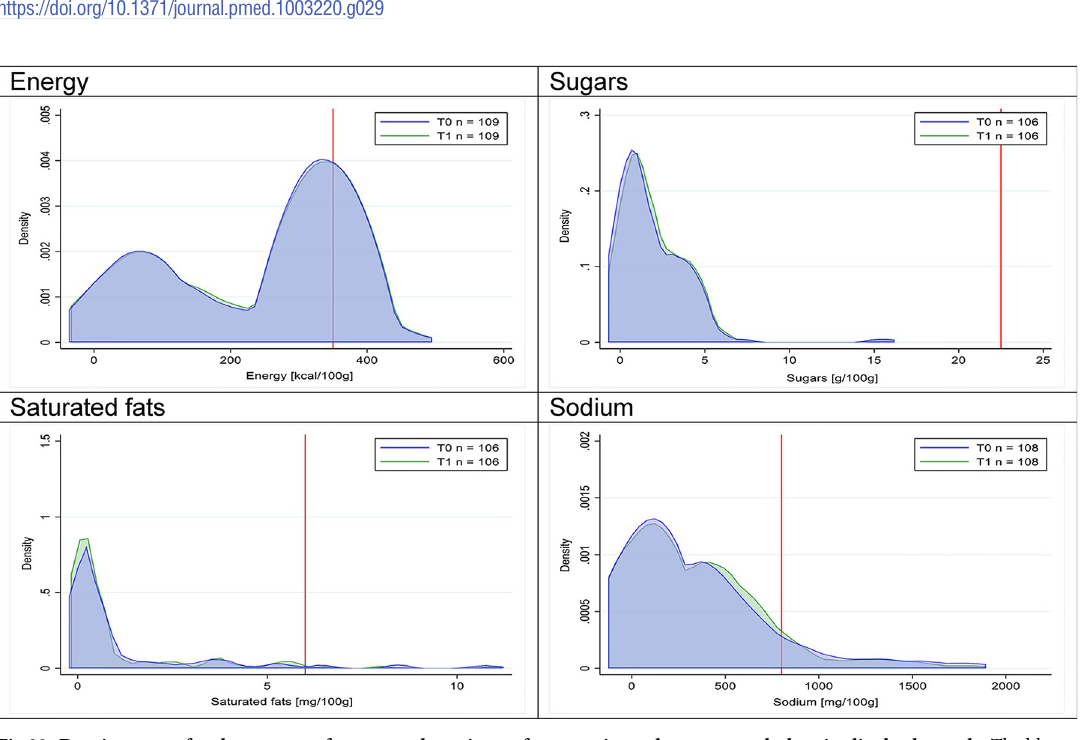
Fig 30. Density curves for the amount of energy and nutrients of concern in ready-to-eat meals, longitudinal subsample. The blue line represents the distribution in T0 (preimplementation), the green line represents the distribution in T1 (postimplementation), and the red line represents the cutoff for the amount of energy or nutrients of